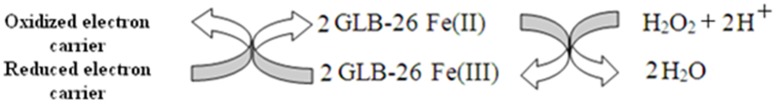
Reduction cycle of GLB-26.GLB-26 can transfer an electron to H2O2, and can in turn be reduced by a yet unknown electron carrier. This electron shuttle results in a prolonged defecation cycle in C. elegans.